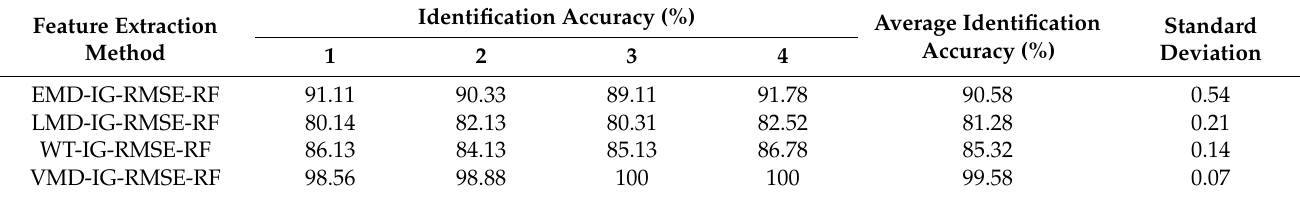
Table 4. Identification accuracy with VMD method and without VMD